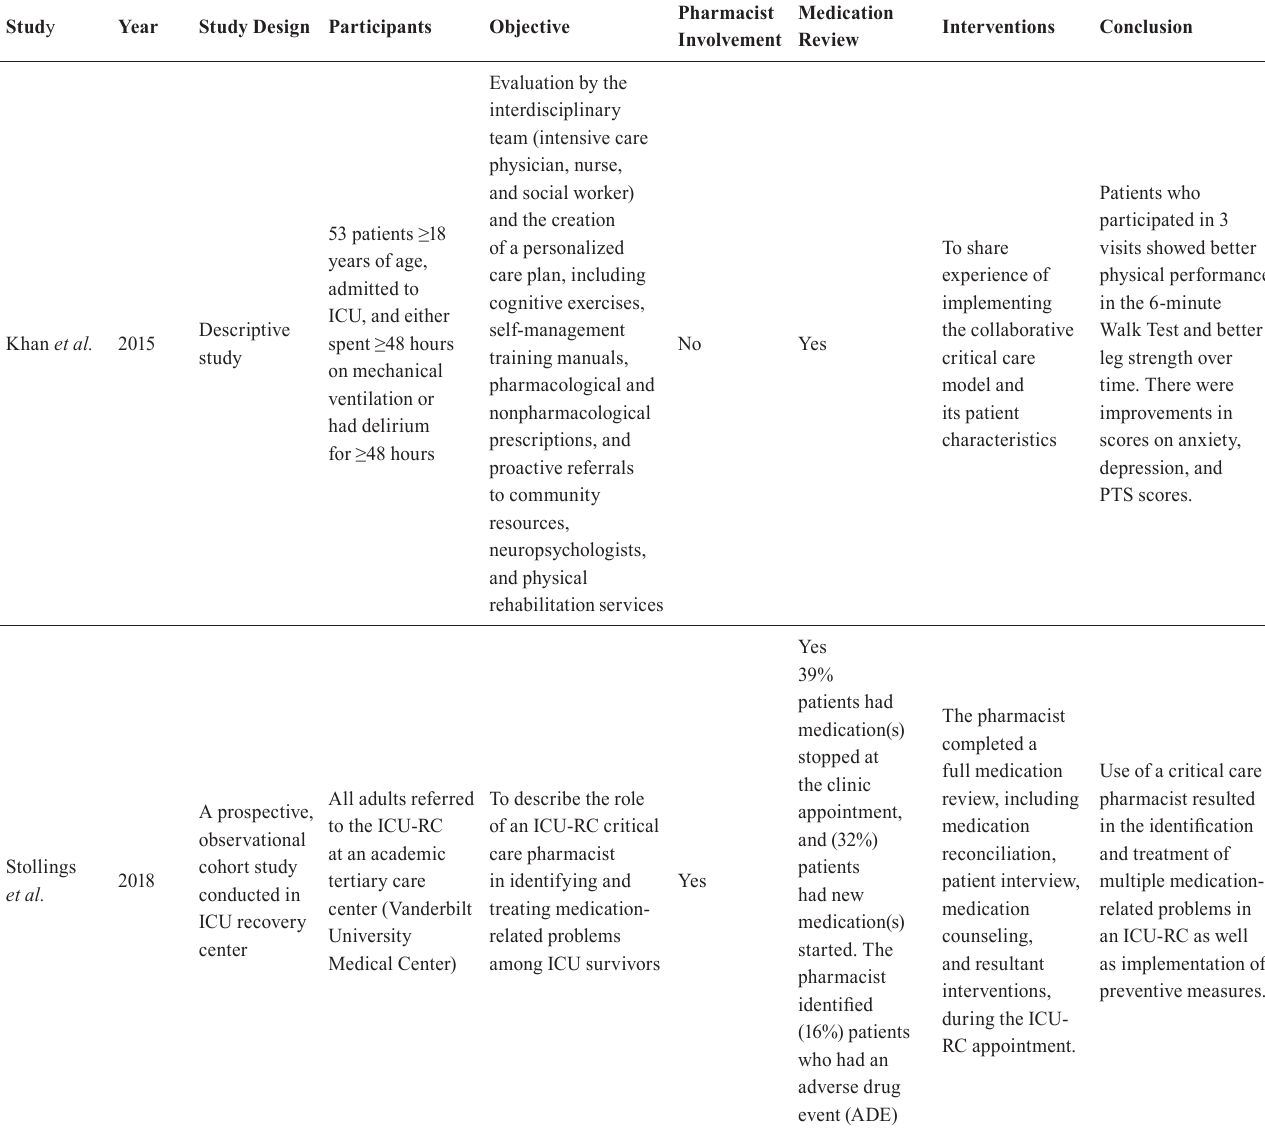
TABLE I - S ummary of the literature related to pharmacist contributions or medication review for post-ICU survivors